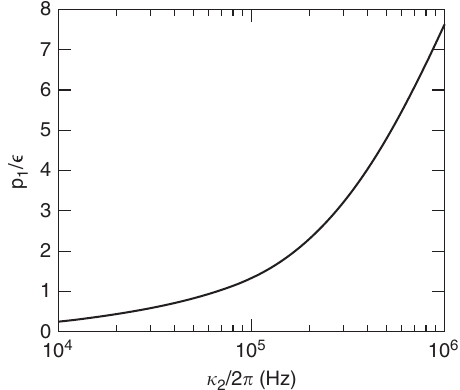
Figure 5 | Incoherent photon contribution. The probability to read out incoherent photons ( p 1 ) normalized by the fraction of atoms ( E ) that have been incoherently transferred to the readout state (|1 i ) as a function of the linewidth, k 2 of the filter cavity. p 1 = E essentially only depends on t read G read and k optical depth of 168 and a finesse of the cell cavity in the range 20–100.